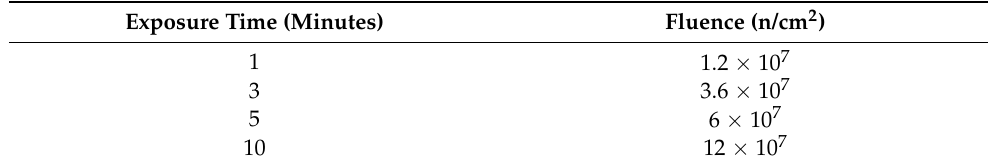
Table 4. The total fluence per sample for different exposure times (L/D = 20).